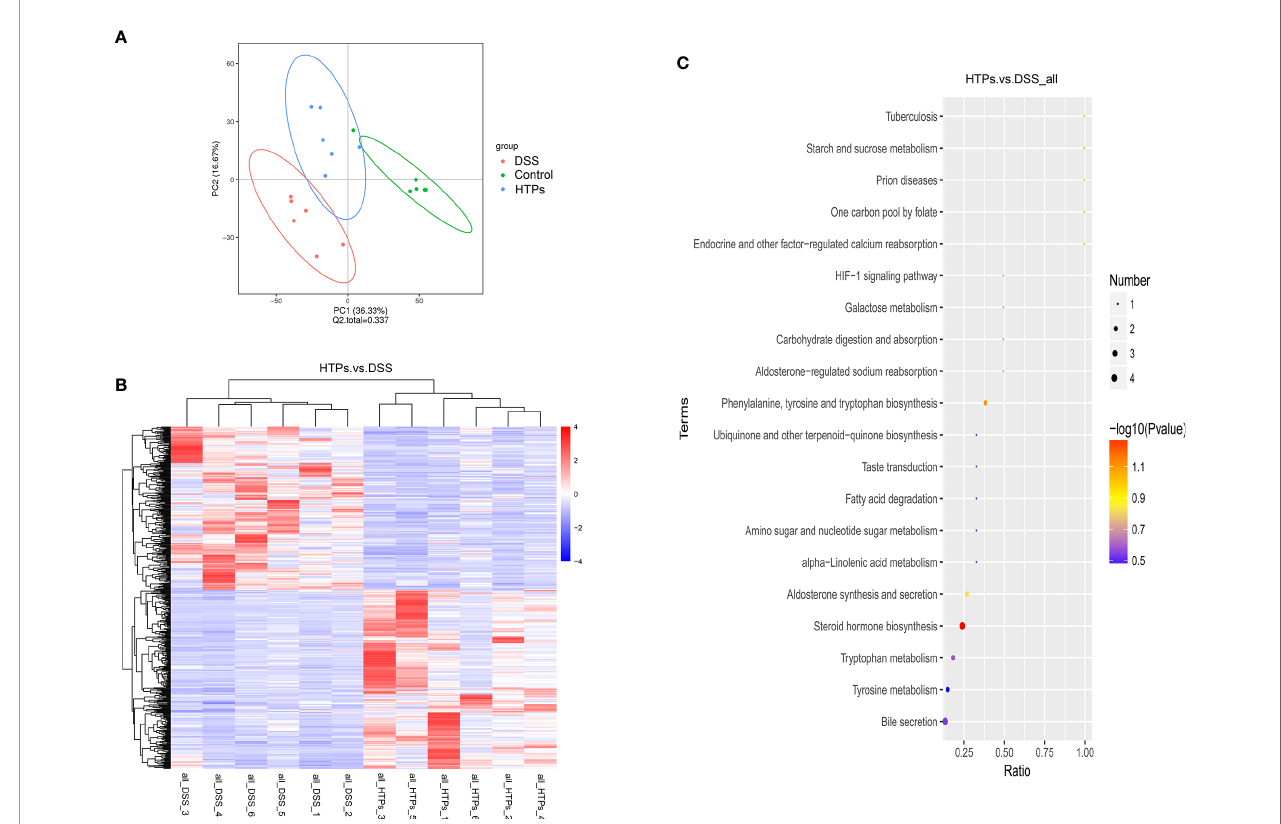
FIGURE 8 | (A) Partial least squares discriminant analysis (PLS-DA) score plots comparing total fecal metabolites in HTPs, DSS and control groups. (B) Hierarchical clustering signi fi cantly changed metabolites of HTPs and control groups. VIP > 1.0, FC > 1.5, or FC < 0.667 and P -value < 0.05. (C) KEGG pathway enrichment of the signi fi cantly changed metabolites of HTPs and control groups. The x -coordinate is the ratio of the number of signi fi cantly changed metabolites in the corresponding metabolic pathways to the total number of metabolites in the identi fi ed pathway. The higher the value, the greater the enrichment of signi fi cantly changed metabolites in the pathway. The color of the dot represents the P -value of the hypergeometric test: the smaller the P -value, the more reliable and statistically signi fi cant the test. The size of the dot represents the number of signi fi cantly changed metabolites in the corresponding pathway. The bigger the dot, the greater the number of signi fi cantly changed metabolites in the pathway ( n =